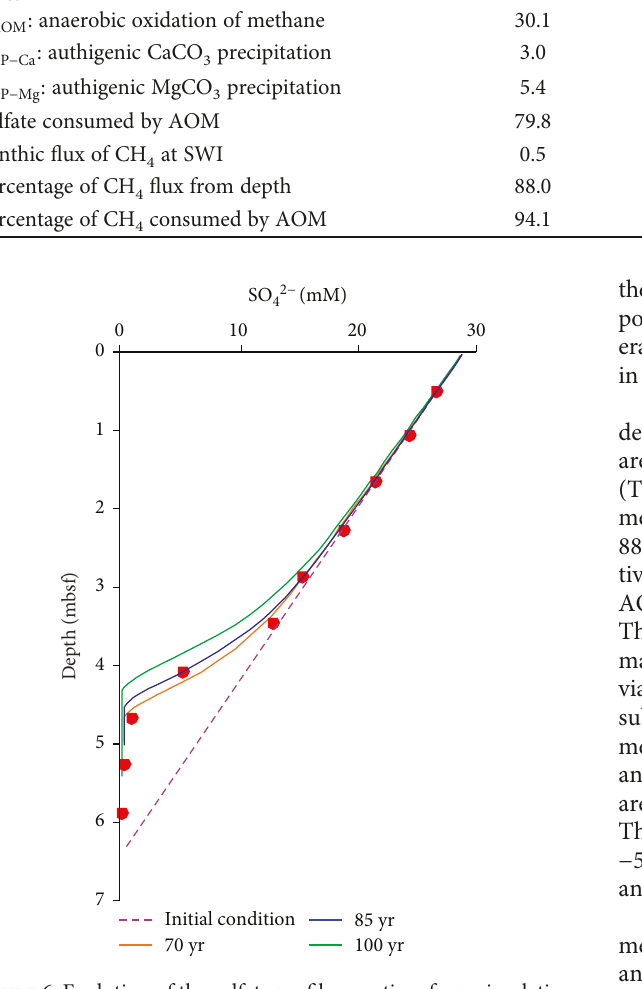
Figure 6: Evolution of the sulfate pro fi le over time from simulation of non-steady-state porewater pro fi les of core